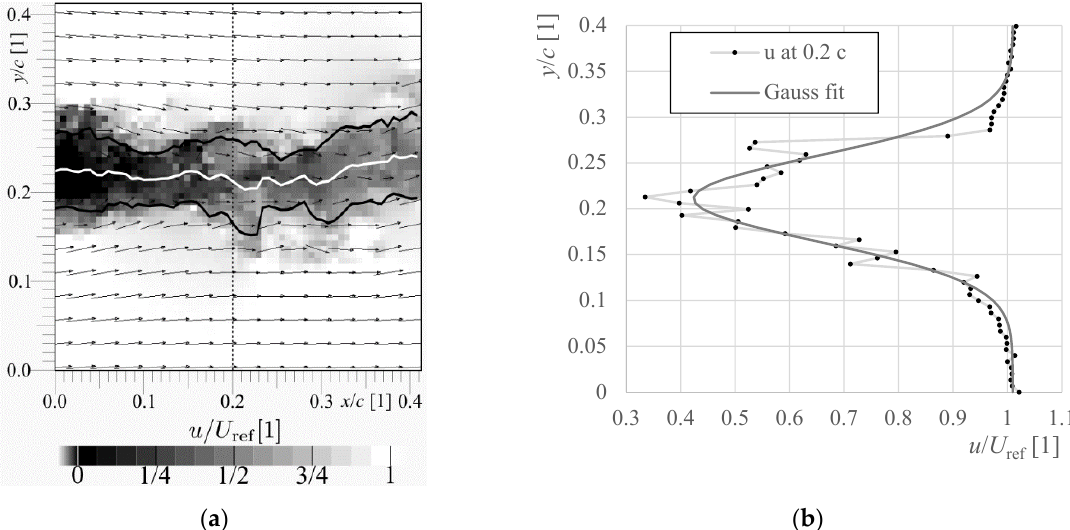
Figure 5. Instantaneous stream-wise velocity. Panel ( a ) shows the map of u (grayscale) normalized by reference velocity. The white line represents the centers of Gaussian fits in transverse profiles, the pair of black lines are the centers plus/minus the σ -parameter of the fit. Panel ( b ) shows a single particular Gaussian fit at the stream-wise distance denoted as dashed line in panel ( a ).